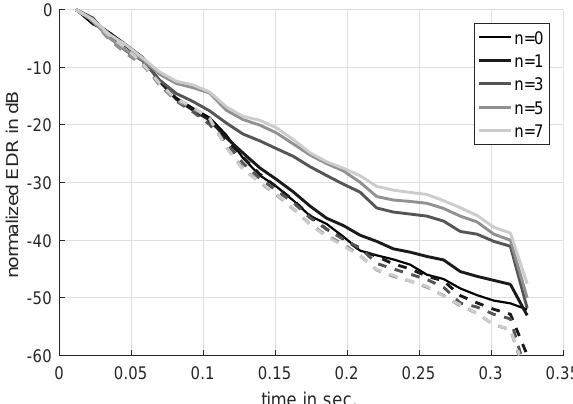
Figure 5. Energy decay relief (EDR) in a third-octave band with center frequency of 2kHz. Solid and dashed lines indicate the order partitioned EDR before and after equalization as defined in Equations (6) and (7),